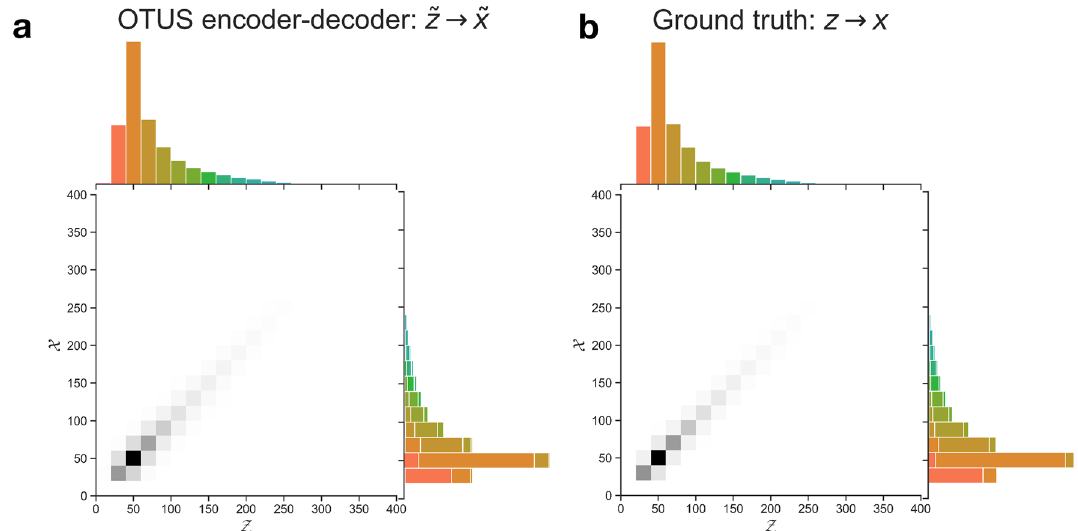
Figure 4. Visualization of the transformation from Z → X in the Z → e + e − study for positron energy. ( a ) The learned transformation of the decoder, p D ( x | z ) . ( b ) The true transformation from the simulated sample, for comparison, though the true ( z , x ) pairs are not typically available and were not used in training. Colors in the X projection indicate the source bin in Z for a given sample.